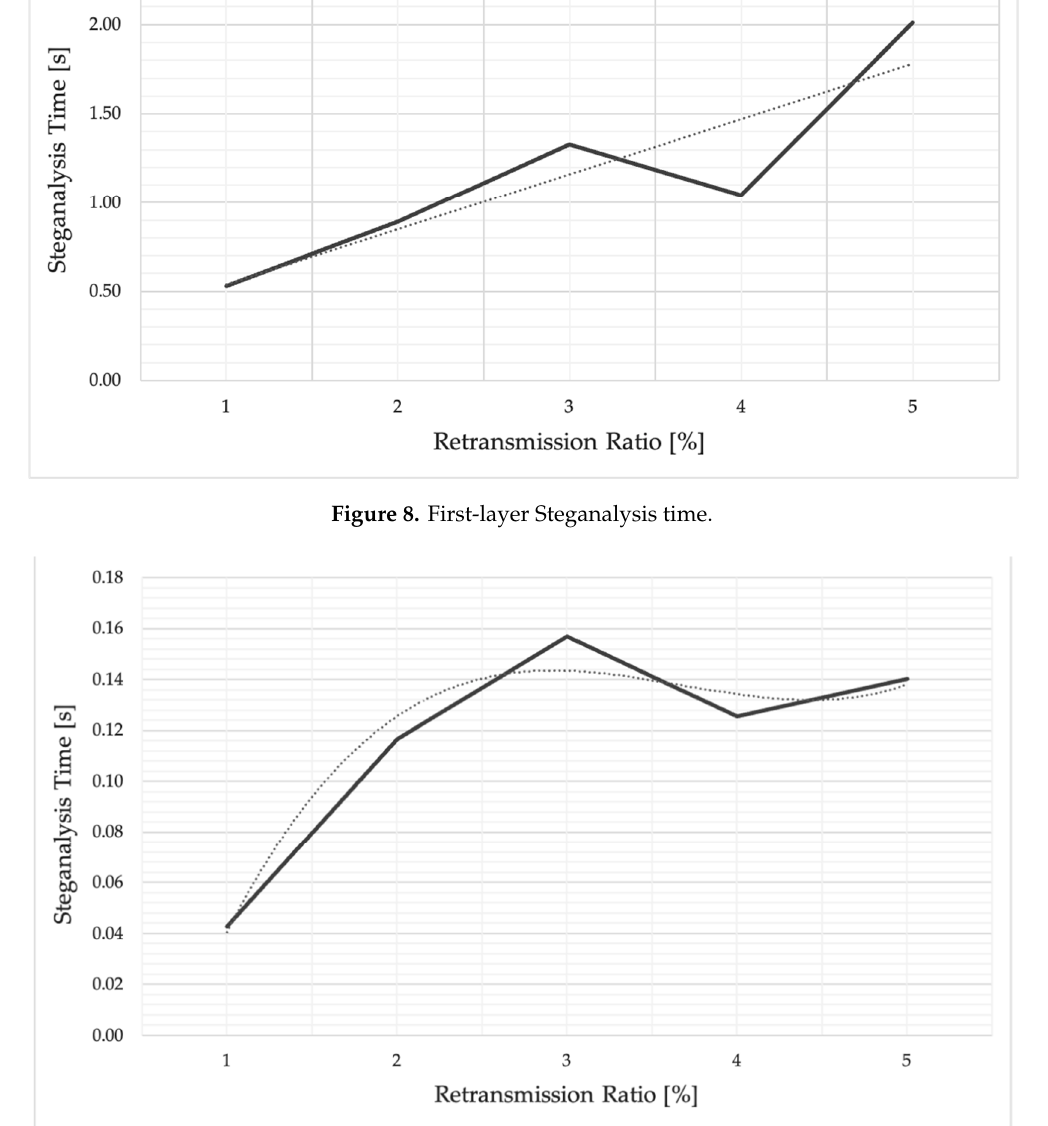
Figure 8. First-layer Steganalysis time .